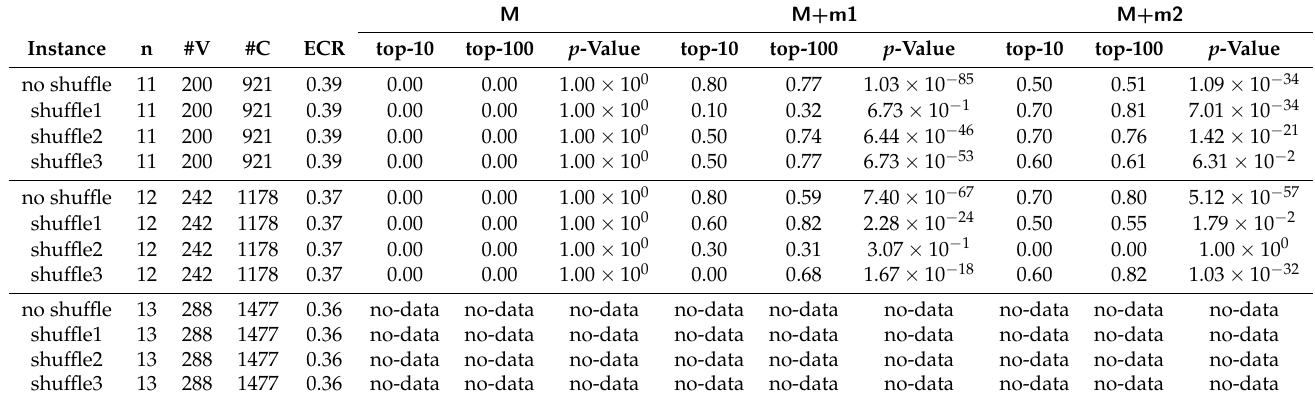
Table 4. DRUP analysis results of PHP instances with full extension for MiniSAT.